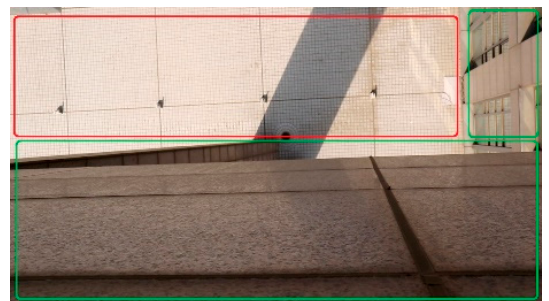
Figure 7. An image sample of the BHDE-v1 dataset. The area inside the red rectangle window is the sparsely depth-annotated plain land, while areas in the green window are not annotated.